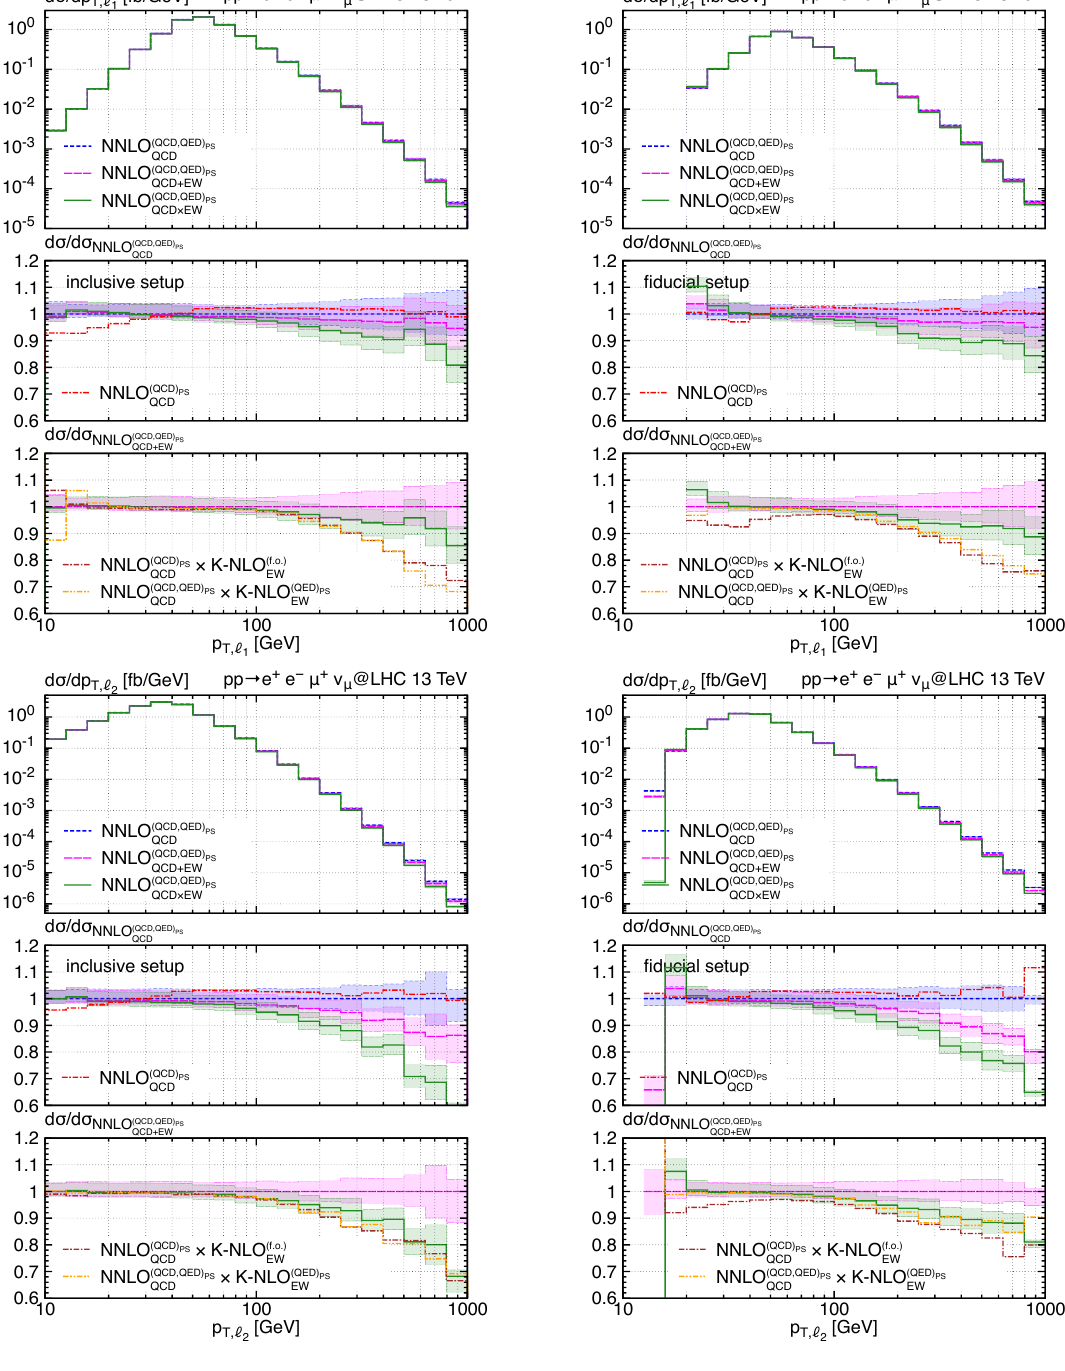
Figure 6. Differential distributions in the leading lepton transverse momentum ( p subleading lepton transverse momentum ( p and fiducial setup (right). See text for